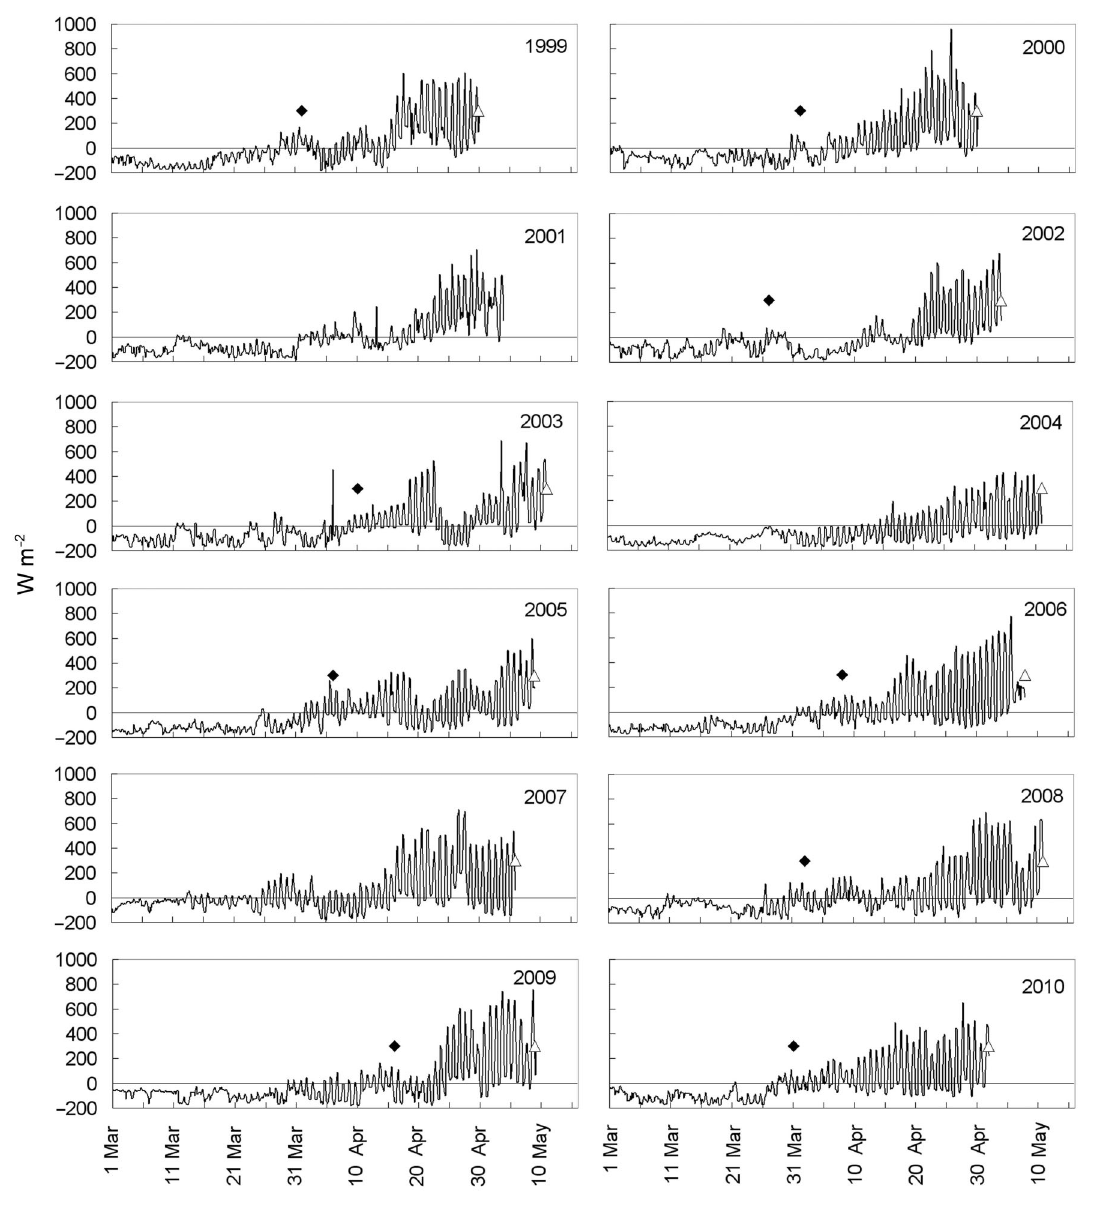
Fig. 2. Surface heat balance during the spring thaw in different years. The black diamond indicates the beginning of under-ice convection, white triangle (cid:150) breaking of the